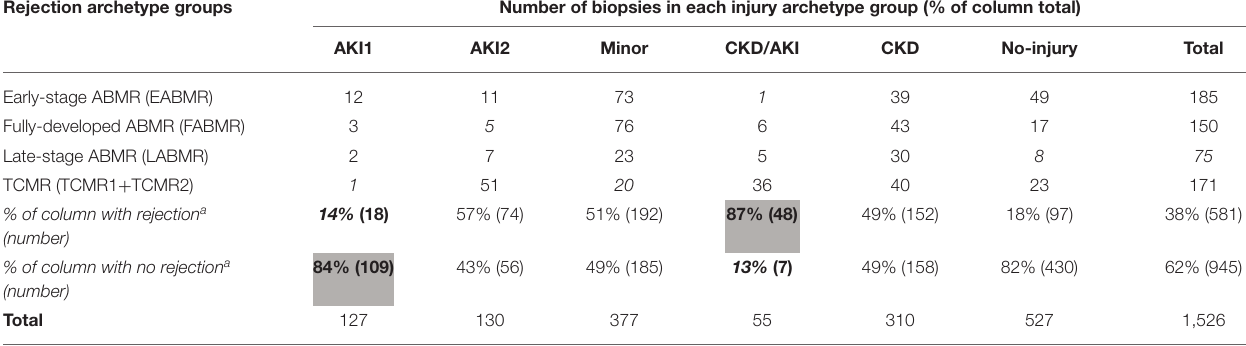
TABLE 3 | Distribution of molecular rejection diagnoses in injury archetype groups. Rejection archetype groups